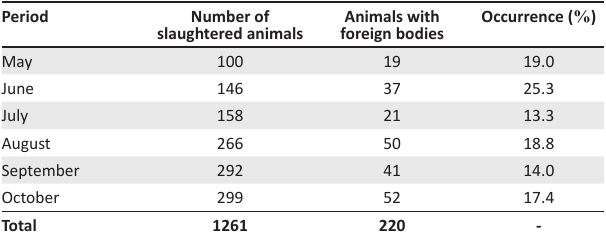
TABLE 1: Occurrence of foreign bodies by month.